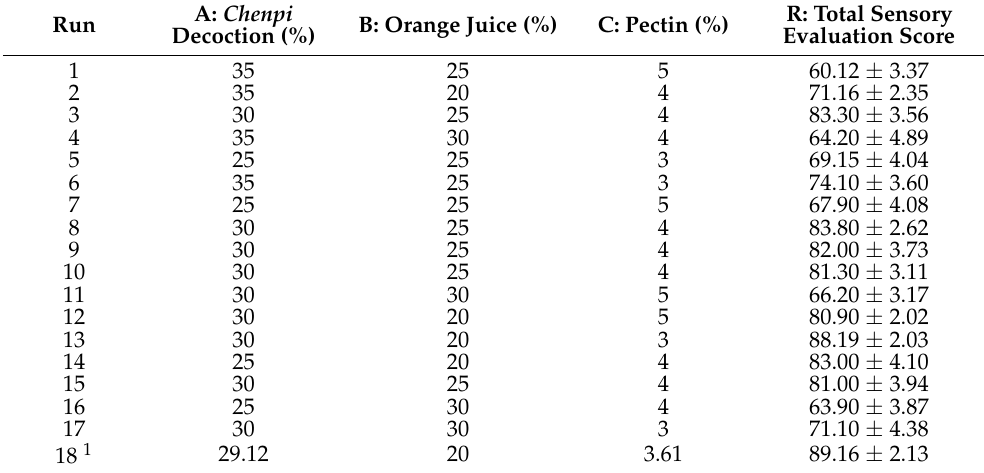
Table 4. Experimental design and the results of the CFJ response surface design.